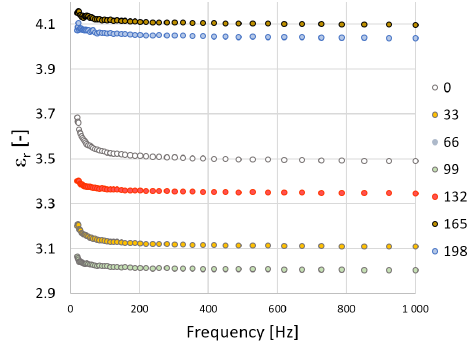
Figure 5. V-TPE-E—measurement course of the relative permittivity in dependence on frequency.